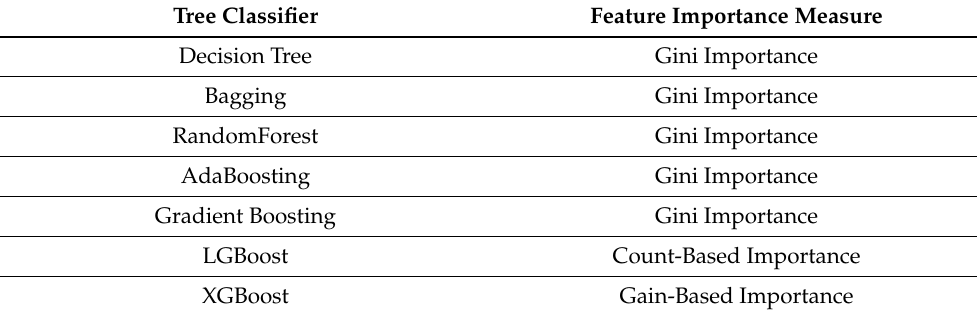
Table 2. Feature importance measures for tree-based